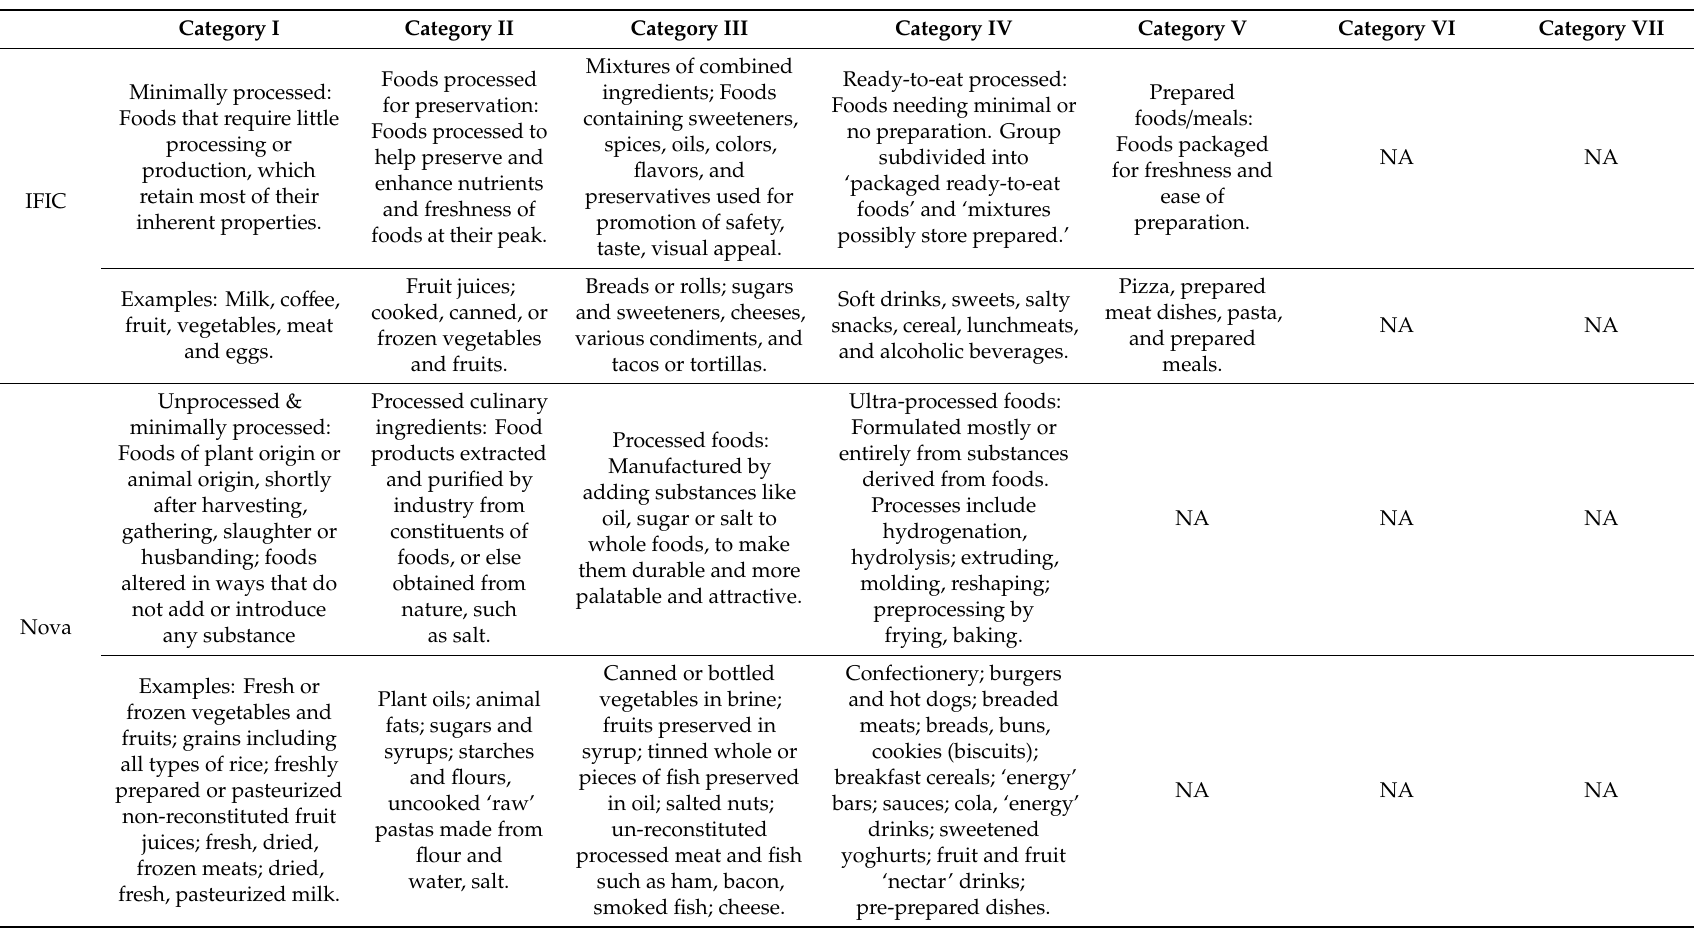
Table 1. Category definitions and criteria for classifying foods and beverages based on degree of industrial food processing according to the IFIC a [15], Nova [14], and UNC b [13]